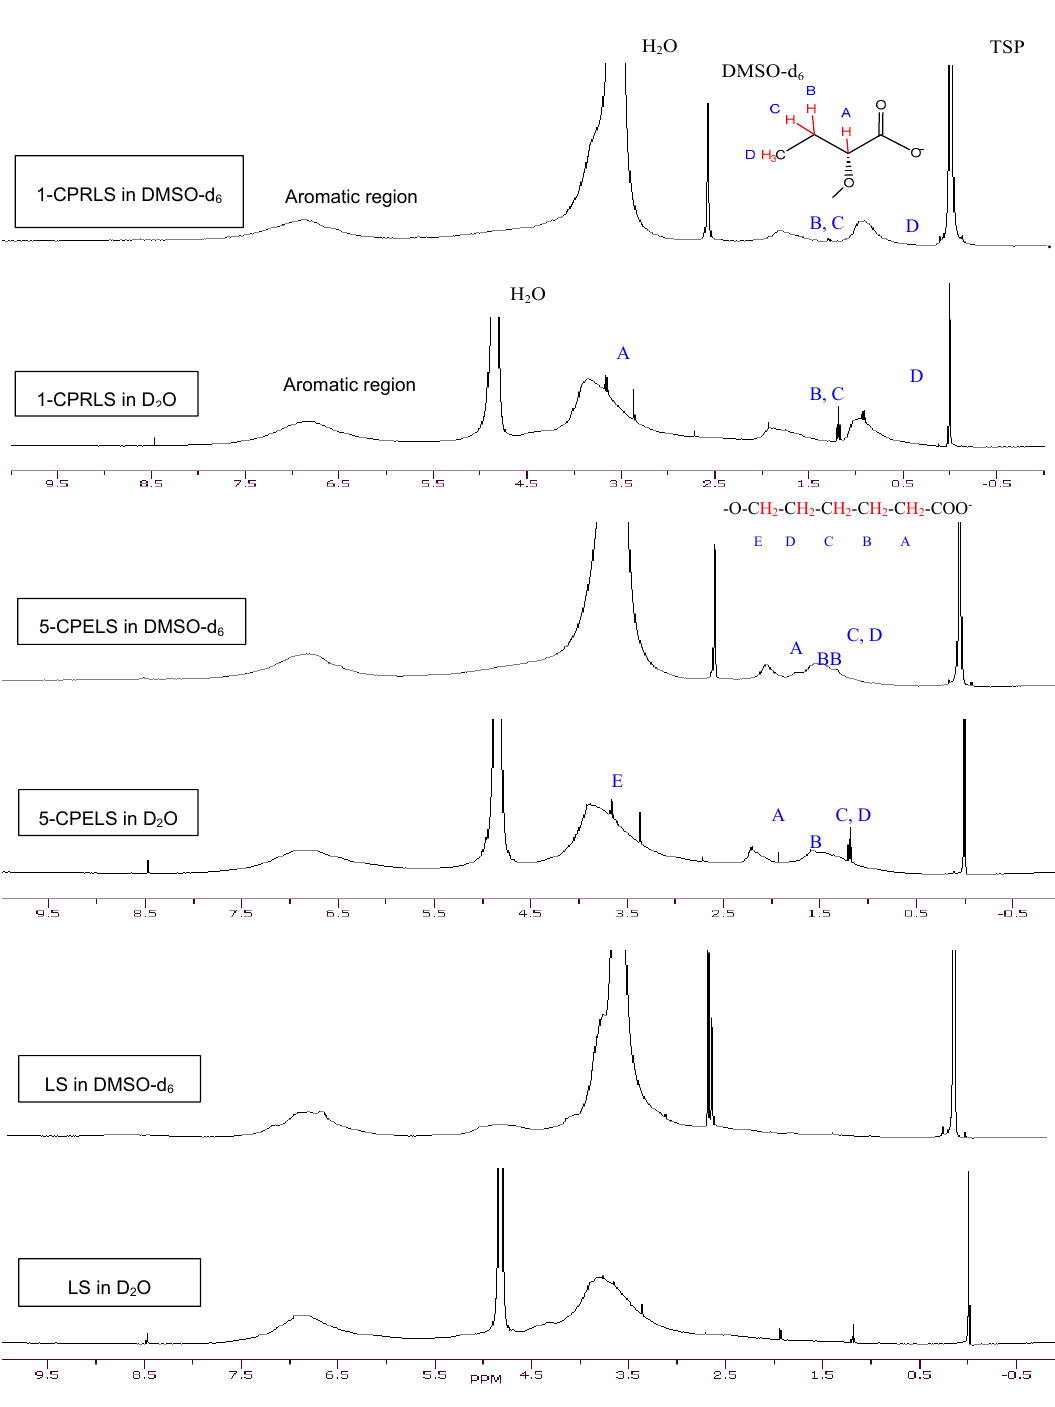
Figure 1. 1 H-NMR spectra of LS, 1-CPRLS, and 5-CPELS in DMSO-d 6 and D 2 O solutions.